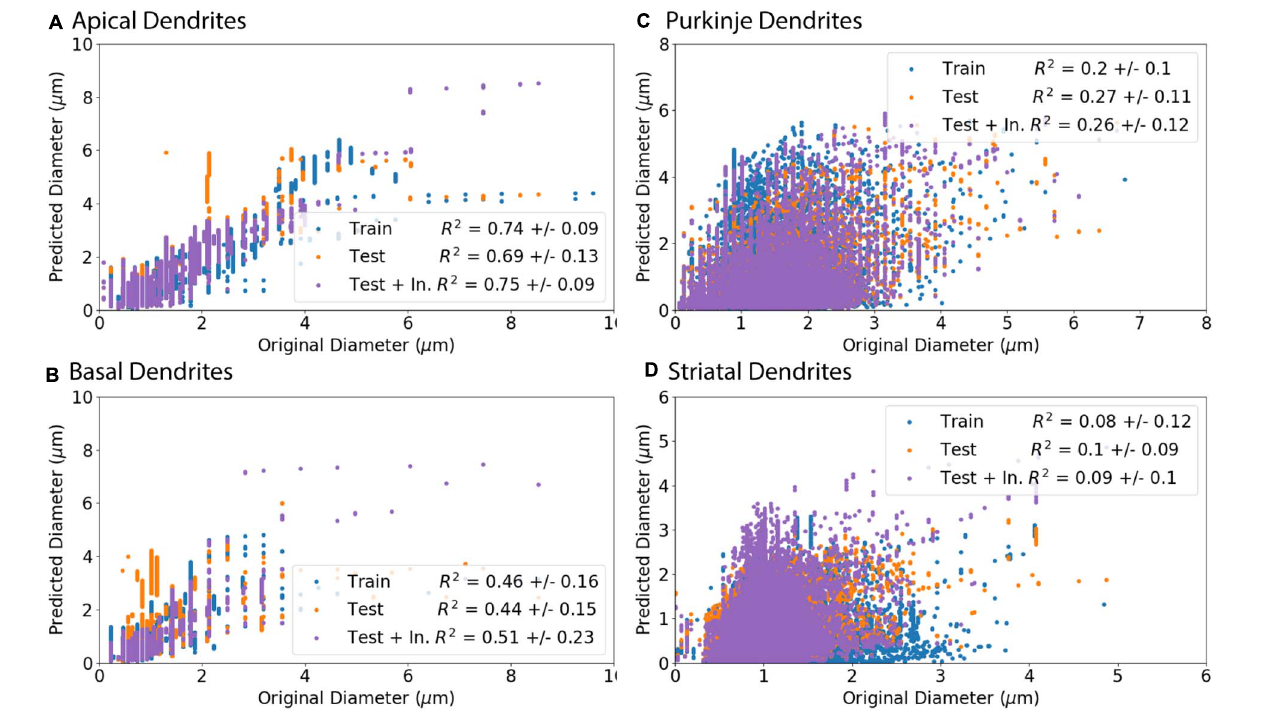
FIGURE 7 | Predicted Diameters match original Diameters for select archives. (A–D) Morphologies were separated into a training set (Train) to create predictive equations and verified with separate testing set (Test). As initial nodes were not predicted as well as branching children or continuing nodes, we created an additional set of morphologies from the test set that used the original diameter of initial nodes and then predicted diameter for remaining branching children and continuing nodes (Test + In.). R 2 is the averaged Pearson’s coefficient of determination R 2 calculated across morphologies in either the training or testing set. Predictions which include original initial diameters have higher correlation with original diameters for apical dendrites ( R 2 = 0.75) and basal dendrites ( R 2 = 0.51) of hippocampal pyramidal cells, though did not improve correlation for cerebellar Purkinje cells ( R 2 = 0.26) or striatal SPNs ( R 2 = 0.09). (A, B) Apical and basal dendrites of hippocampal pyramidal with 8 in the training set and 9 in the testing set. (C) Cerebellar Purkinje morphologies with 18 in the training set and 18 in the testing set. (D) Striatal SPN morphologies with 19 in the training set and 19 in the testing